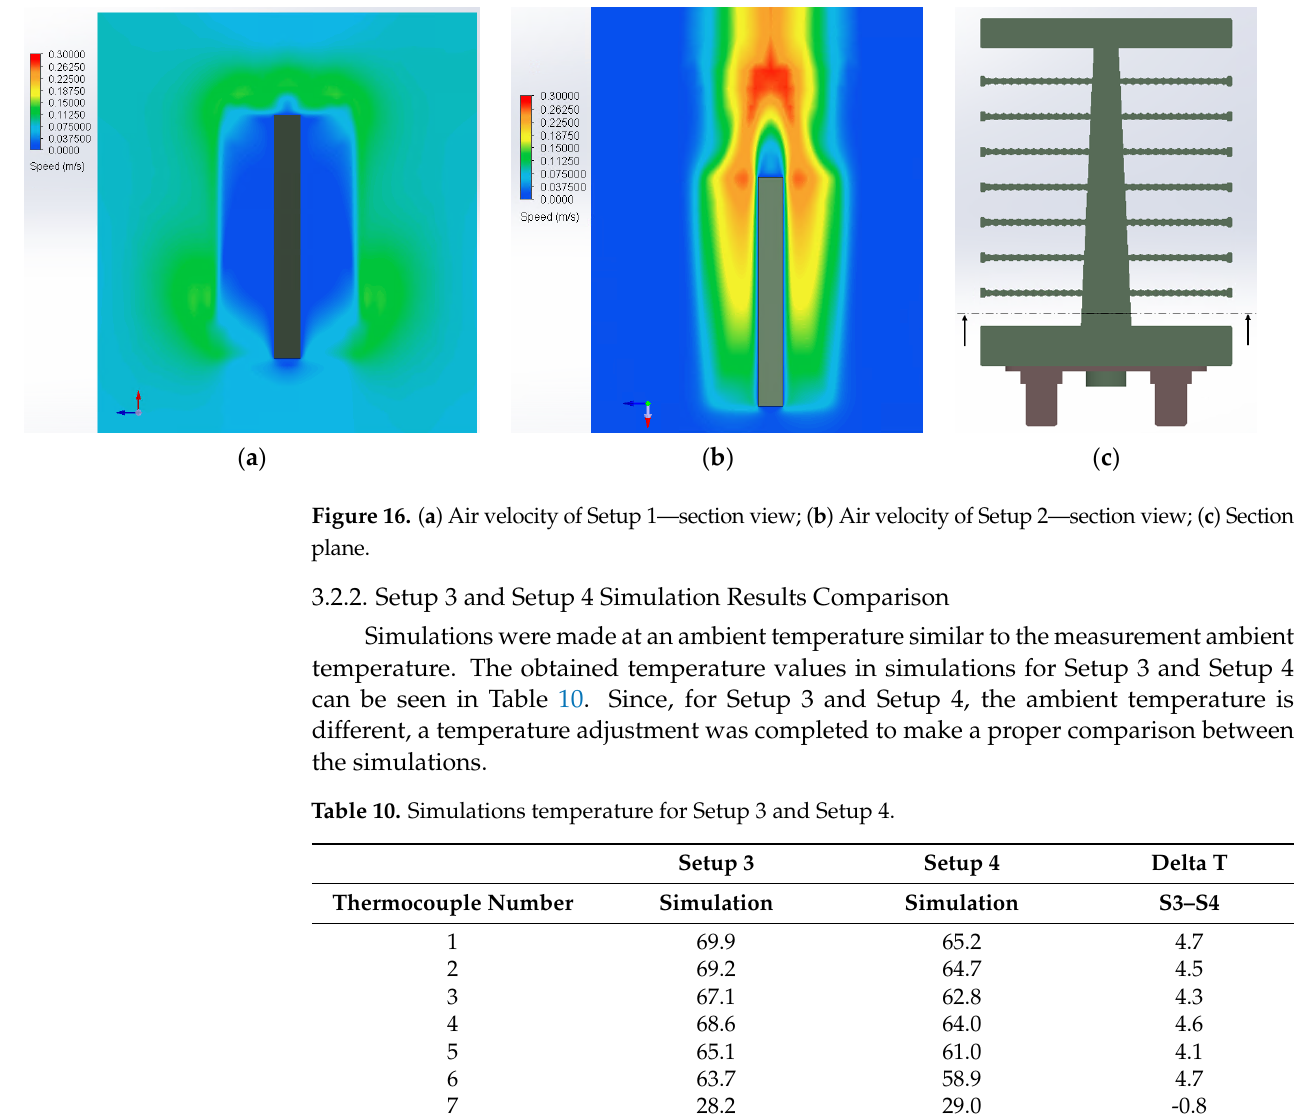
Table 11. Simulations temperature for Setup 3 and Setup 4 with adjusted temperatures for Setup 4.